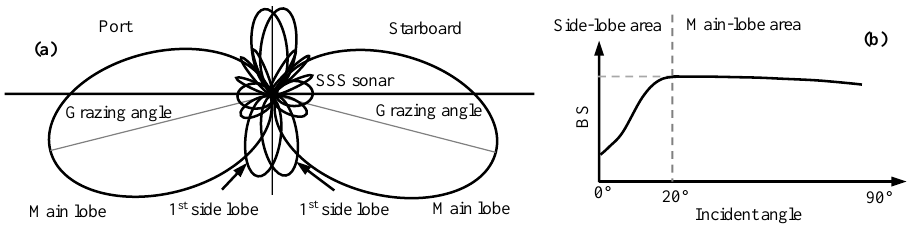
Figure 2. ( a ) Main and side lobes of a side-scan sonar; and ( b ) angle–BS curve of the sonar beam